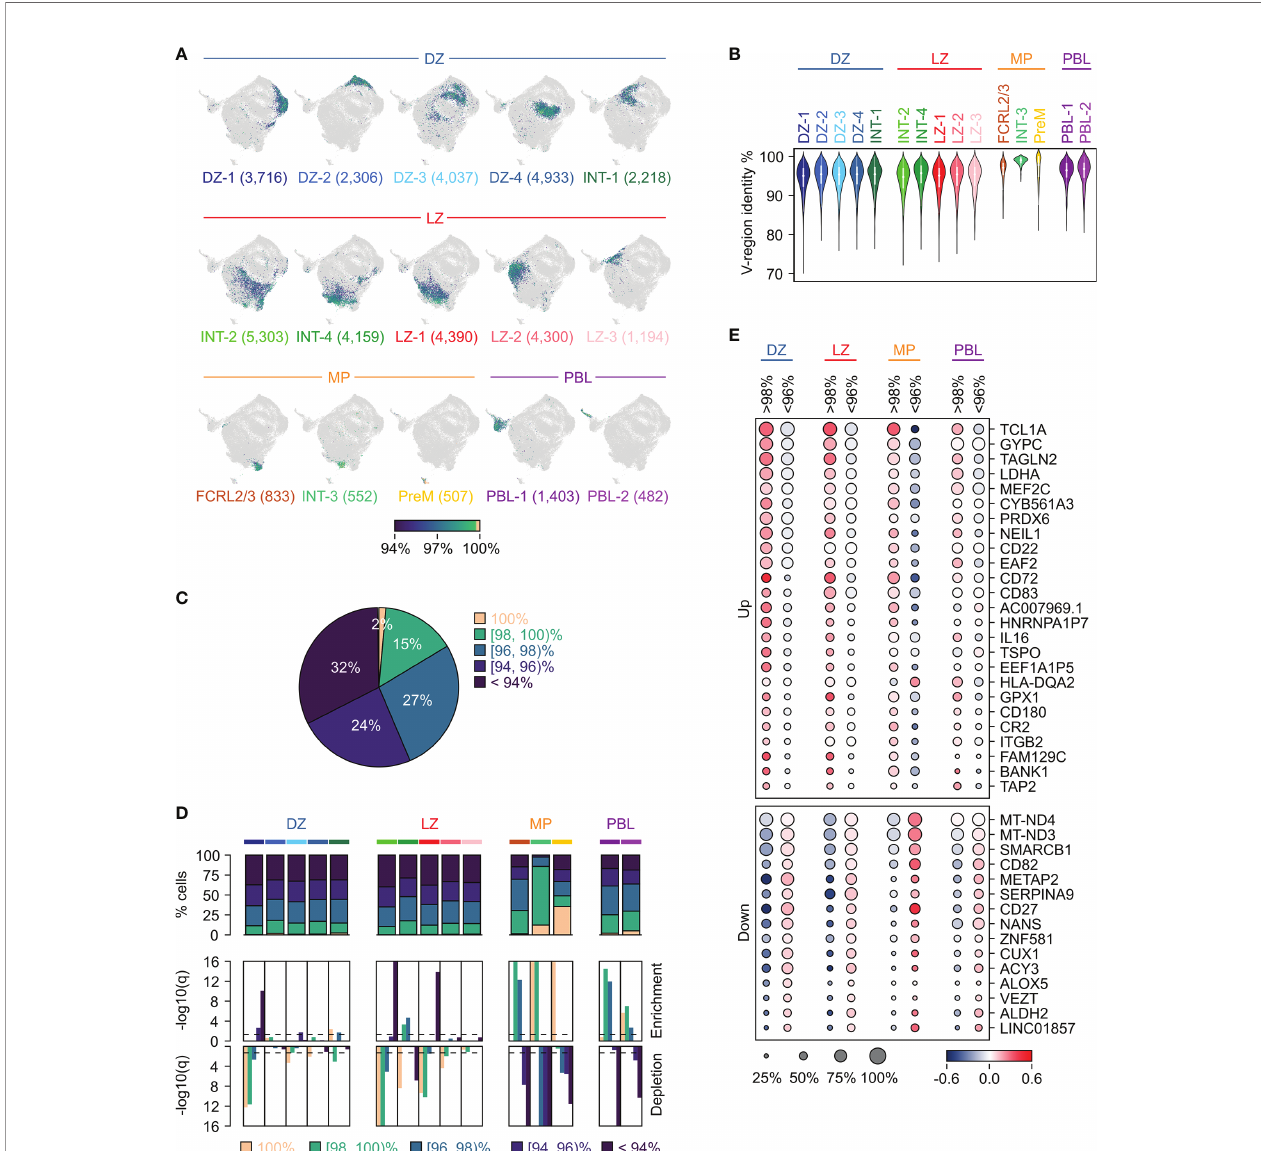
FIGURE 2 | Tracking the immunoglobulin variable region mutation load in GC B cell subpopulations. (A) UMAP projection in which cells in each cluster are labeled based on the germline identity of the variable (V)-regions of the heavy and light immunoglobulin chains. The color scale re fl ects the percentage of the V-region germline identity with a range from 100% (peach) to 94% or less (dark blue). The number of cells belonging to each cluster is provided in parenthesis. Clusters are organized in four groups (DZ, LZ, memory precursors MP, PBL) based on their similarities. (B) Violin plots showing the distribution of the V-region germline identity in each GC cluster. (C) Distribution of GC B cells into fi ve subgroups based on the V-region germline identity. (D) Stacked bar plot showing for each GC cluster the percentage of cells within the V-region germline identity subgroups (top panel). Enrichment (middle panel) and depletion (bottom panel) analyses of the mutational load in the GC clusters (hypergeometric test with Benjamini-Hochberg correction, q < 0.05). (E) Differential gene expression analysis between cells with high (>98%) and low (<96%) V-region germline identity in each of the major GC groups (DZ, LZ, MP and PBL). The size of the dot indicates the percentage of cells with detectable expression, and the color re fl ects the relative gene expression shown as the z-scored average (log2) normalized expression within a